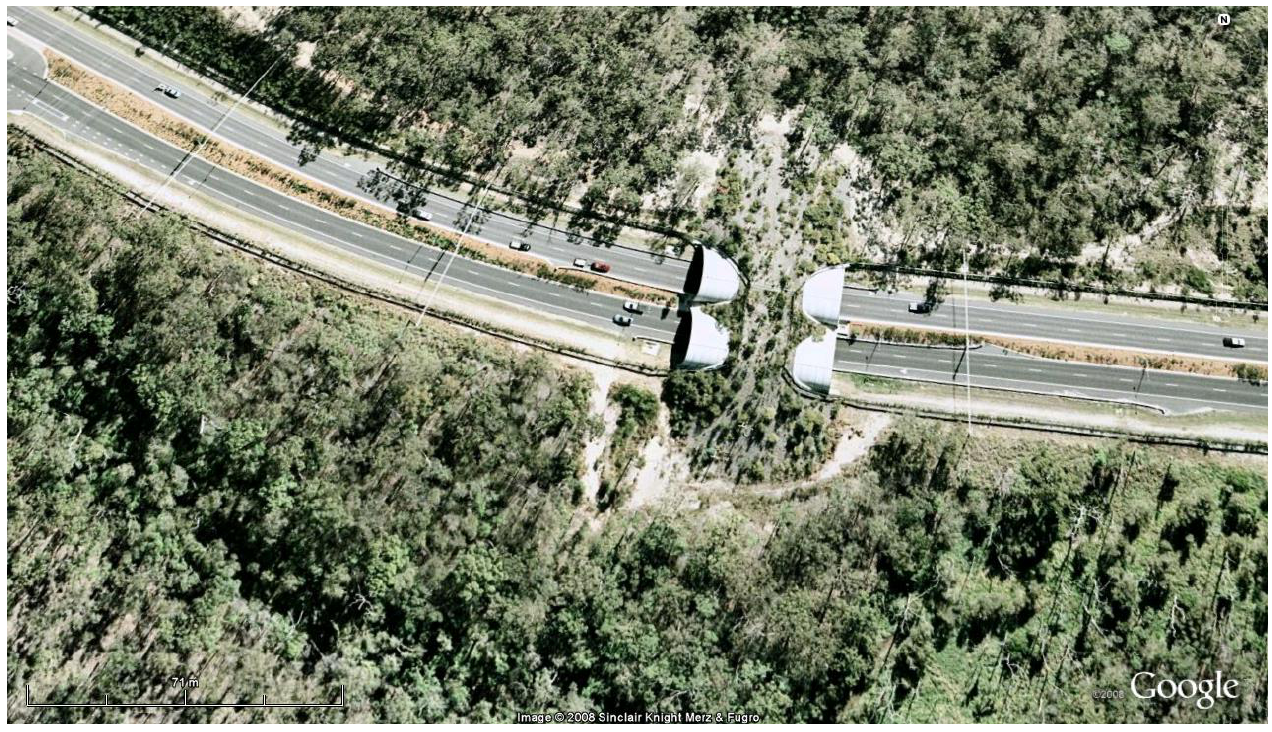
Fig. 2. An aerial view of the land bridge over Compton Road, connecting Karawatha Forest (below) to Kuraby Bushland (above). Three rope canopy bridges spanning the road can be seen as thin white lines. The canopy gap created by the four-lane road is approximately 50 m. Source: Google